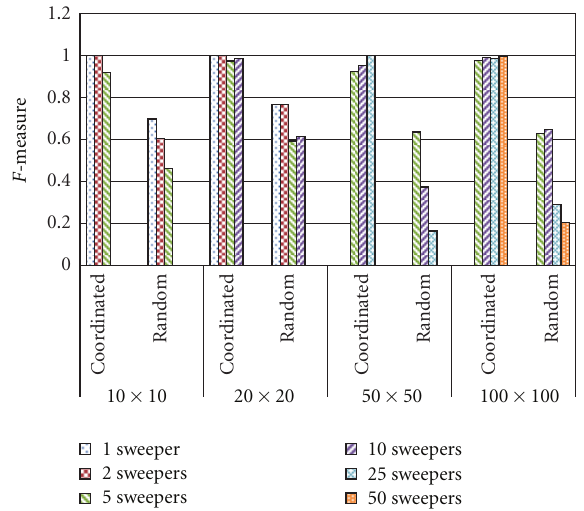
Figure 7: F -measure in coordinated versus random motion model.